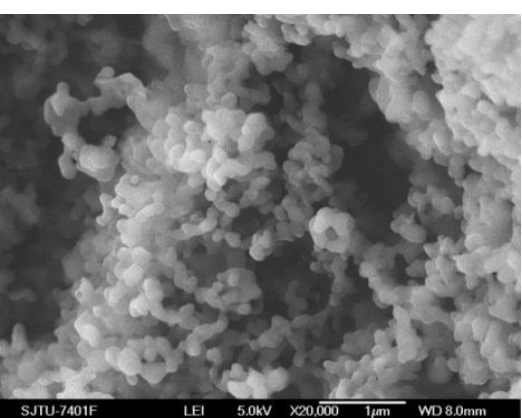
A 8 MPa, 35 °C, 1.0 mg/mL, 1.0 mL/min B 10 MPa, 35 °C, 1.0 mg/mL, 1.0 mL/min